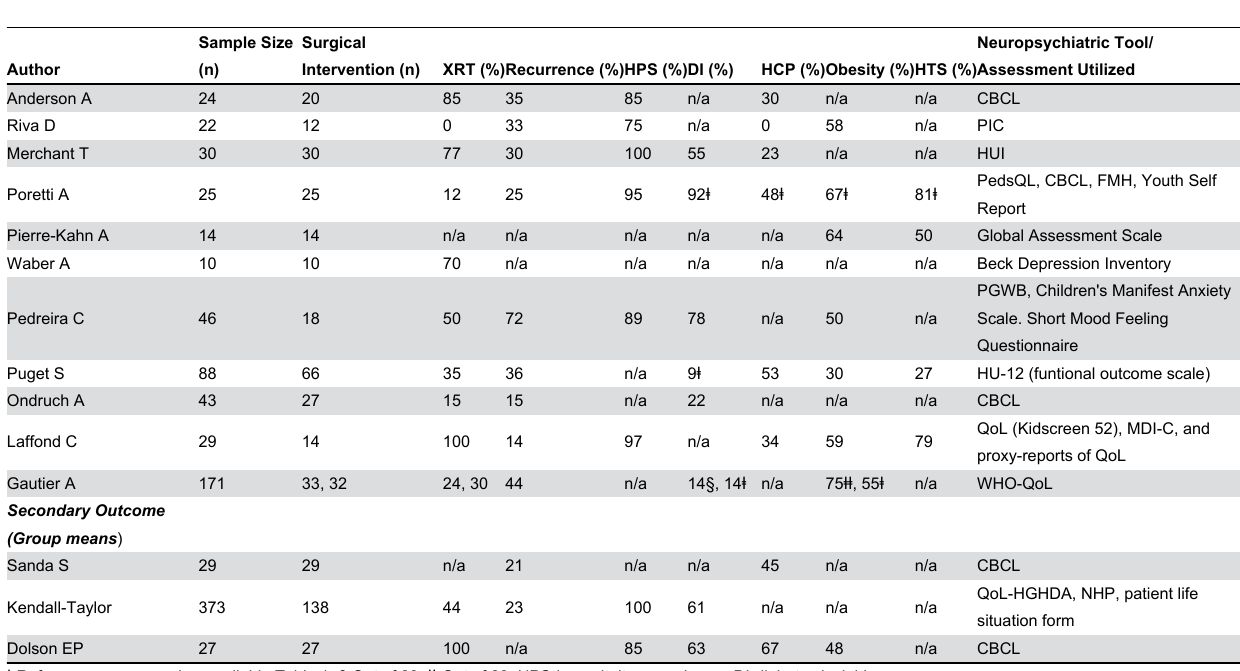
Table 2. Interventions and co-morbidities of the sample